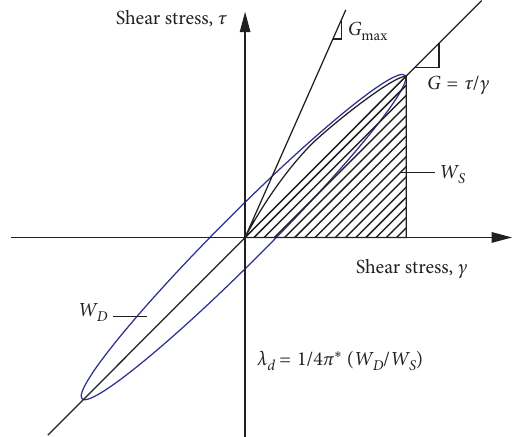
Figure 9: Hysteresis loop for one cycle of loading showing the calculation method of damping ratio in theory.